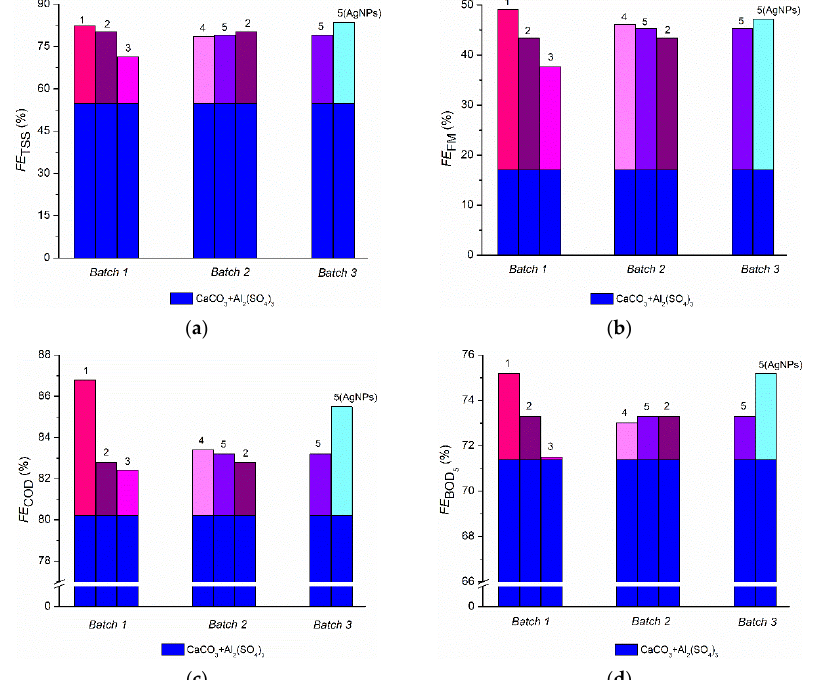
Figure 2. Results of the flocculation study at laboratory level: ( a ) total suspended solids ( TSS ), ( b ) organic matters ( FM ), ( c ) chemical oxygen demand ( COD ), and ( d ) biochemical oxygen demand ( BOD 5 ). The coagulation–flocculation experiments involved inorganic coagulants (CaCO 3 and Al 2 (SO 4 ) 3 –blue color) and aqueous solution flocculant (graft